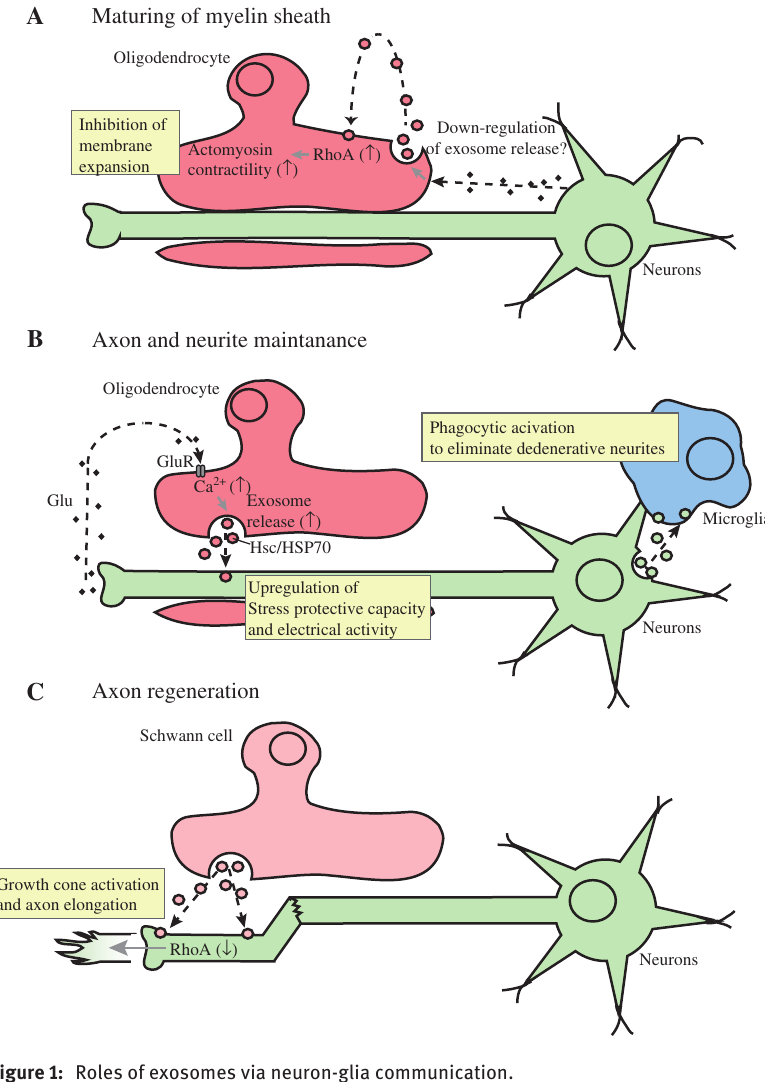
Figure 1: Roles of exosomes via neuron-glia communication. (A) Oligodendroglial exosomes autonomously inhibit myelin sheath formation through RhoA-actomyosin signaling. As yet unknown secreted molecules from activated neurons inhibit oligodendroglial exosome release. (B) Electrically active neurons release glutamate (Glu). Glu stimulates oligodendrocytes to release exosomes through the Glu receptor (GluR)-mediated Ca 2 + influx. The exosomes are taken up into neurons in where the effects of their cargos such as Hcp/HSP70 are exerted. Neuronal exosomes accelerate phagocytic activity in microglia. (C) Exosomes released from Schwann cells are selectively incorporated into axons. The exosomes activate growth cones, which leads to the elongation of injured